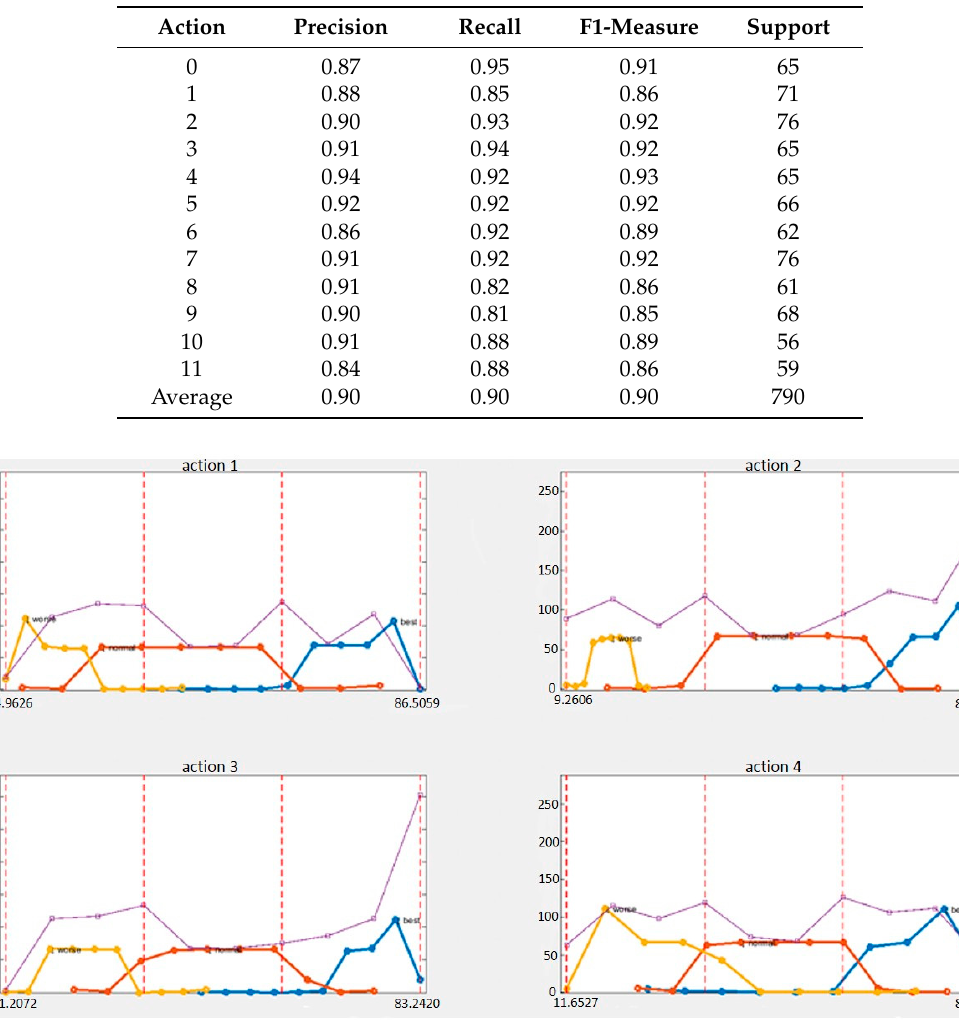
Figure 9. Score distribution of all actions for all levels.